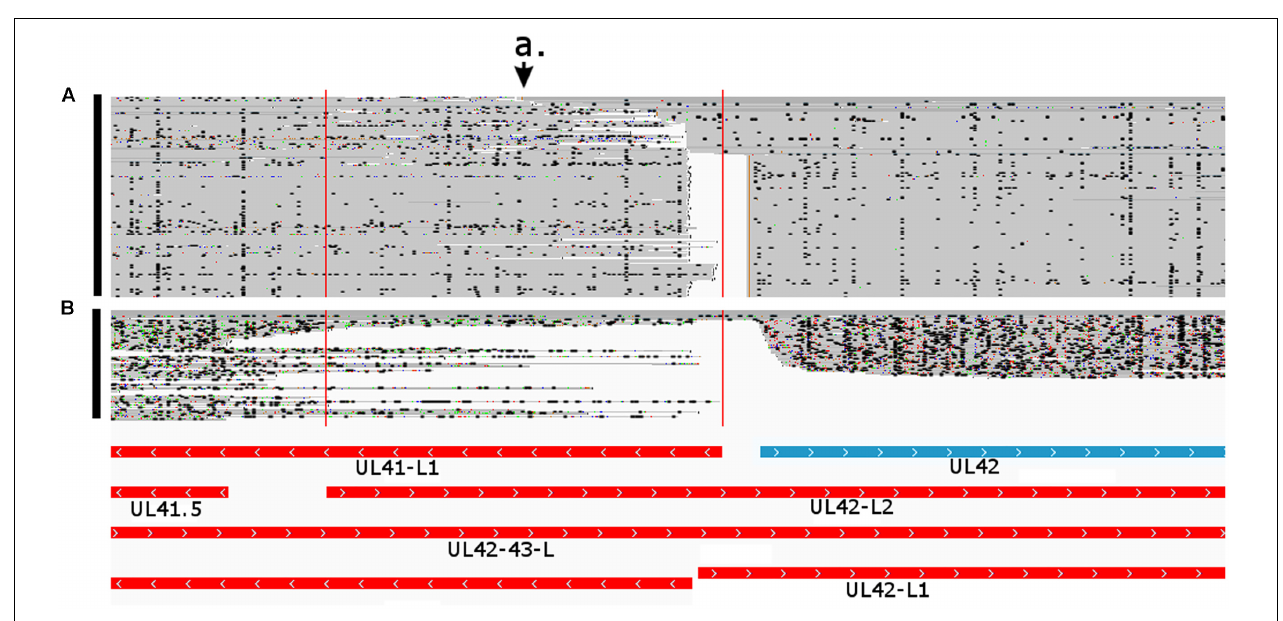
FIGURE 6 | Convergent transcriptional overlap of UL43-44-AT and UL26.5. The arrow a. points to the overlapping region delimited by the vertical red lines. The blue box represents the already known UL26.5 transcript, while the red box represents the novel UL43-44-AT transcript. Reads of the PacBio IsoSeq (A) and MinION Direct RNA (B) sequencing were visualized in compact mode using IGV.